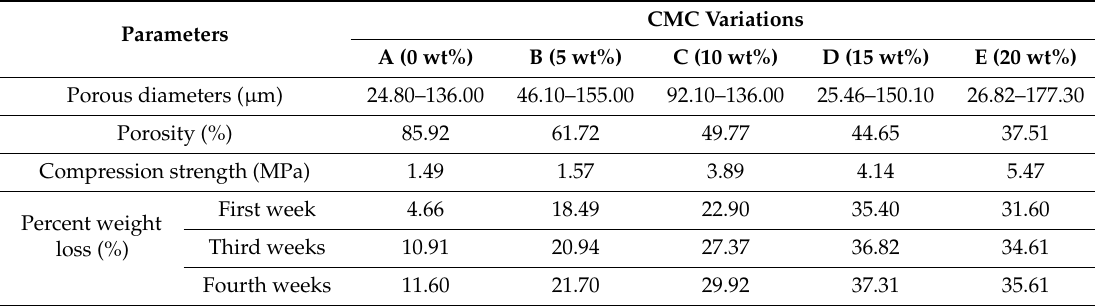
Table 2. Compilations of porosity, mechanical strength, and biodegradability data from